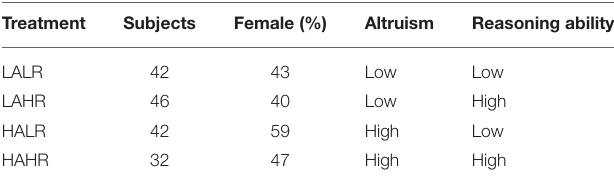
TABLE 1 | Treatments summary.